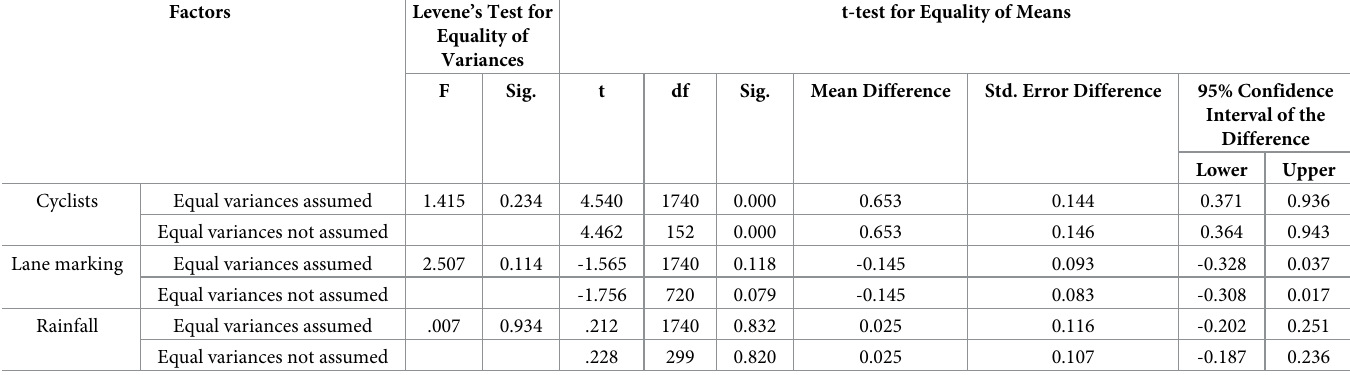
Table 2. Significance